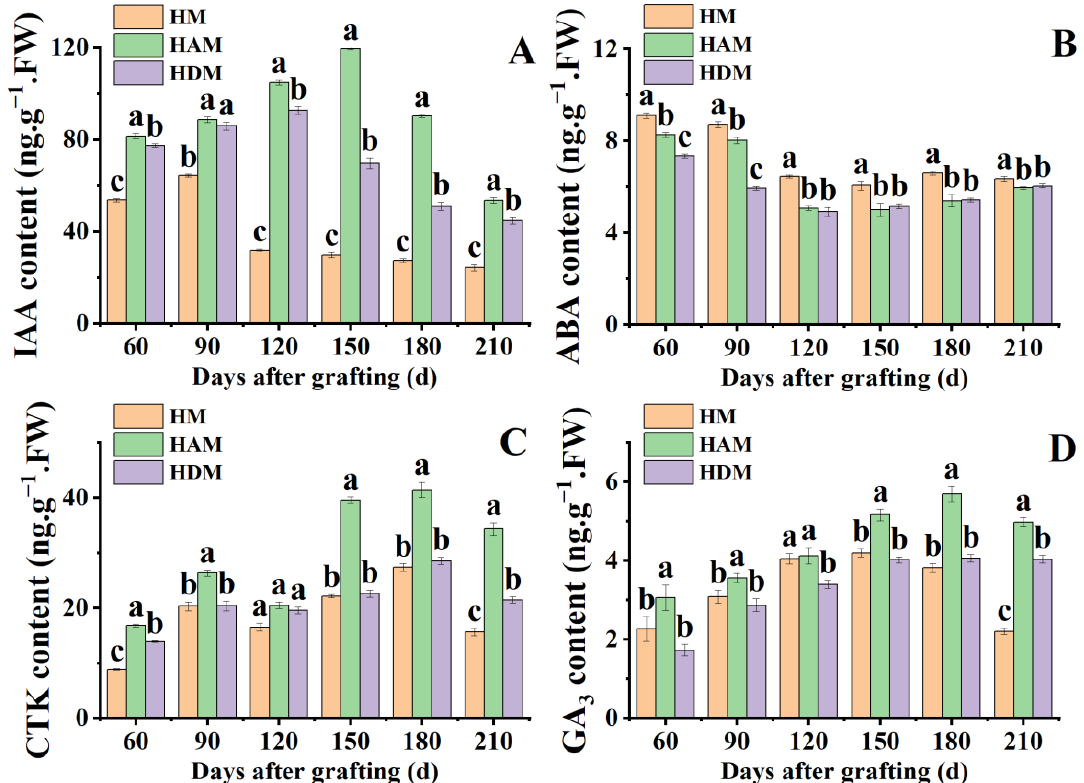
Figure 3. The phytohormone levels in leaves under different interstock treatments. ( A ) IAA: indole-3-acetic acid, ( B ) ABA: abscisic acid, ( C ) CTK: cytokinin, ( D ) GA 3 : gibberellin A 3 . Data were the mean ± standard error of three replicates. Error bars indicate the standard error, and different letters indicate significant differences, p < 0.05.